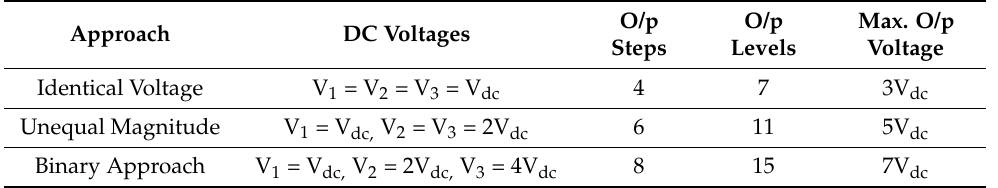
Table 1. Choice of DC voltages for the proposed MLI topology.